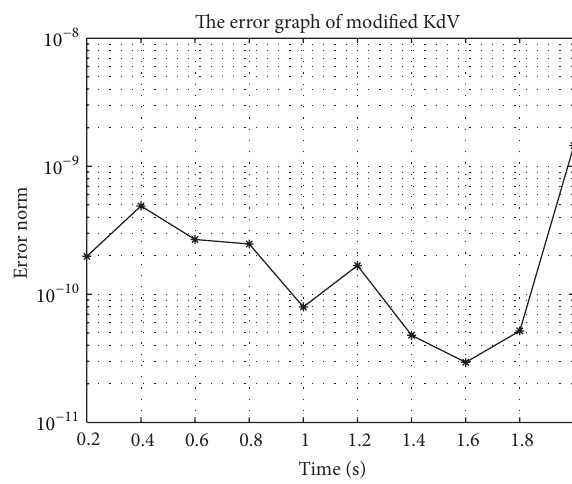
Figure 9: Fitzhugh-Nagumo equation error graph.